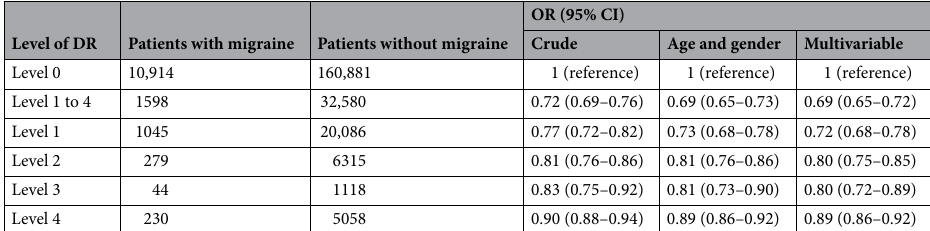
Level of DR Patients with migraine Patients without